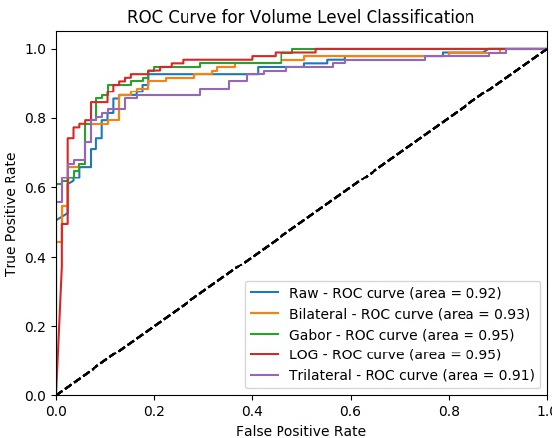
Figure 38. ROC curves from volume-level classification for each SFMPF model.